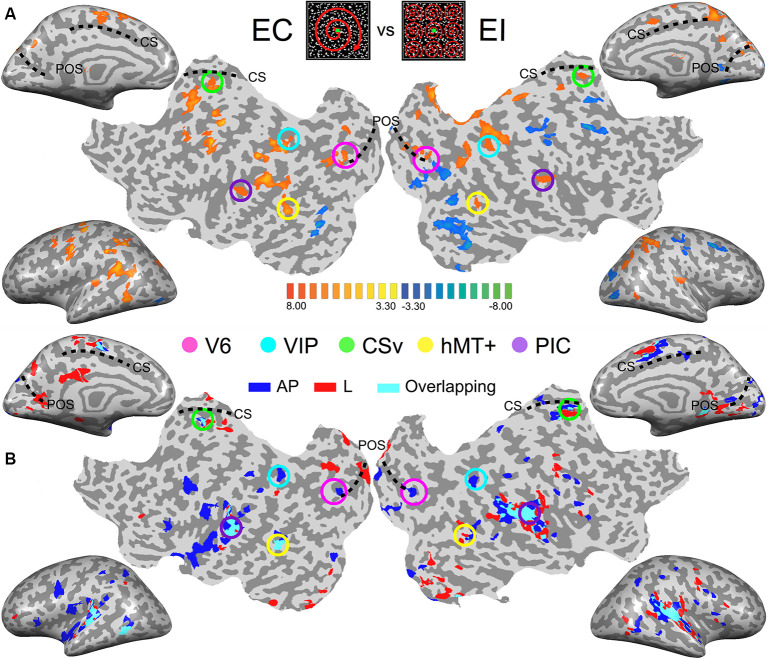
Images from the brain of one participant showing the key results. (Top-center patches) Egomotion-consistent (EC) and egomotion-inconsistent (EI) optic flow patterns used as localizers stimuli. (A) Contrast between the cortical responses recorded during the egomotion consistent (EC) vs. inconsistent (EI) optic flow conditions. Data are shown on inflated cortical surfaces and flat maps for the left and right hemispheres (p < 0.001, uncorrected). The positions of the parieto-occipital sulcus (POS) and cingulate sulcus (CS) are provided as anatomical landmarks. Colored circles outline the five Regions of Interest (ROIs) in this subject. (B) Responses during the galvanic stimulation (GVS) experiment for the same participant. Voxels whose activations were stronger during GVS conditions than during baseline were colored in blue (antero-posterior, AP), red (lateral, lat) and cyan (both) before being superimposed transparently on the inflated brain and flat maps.